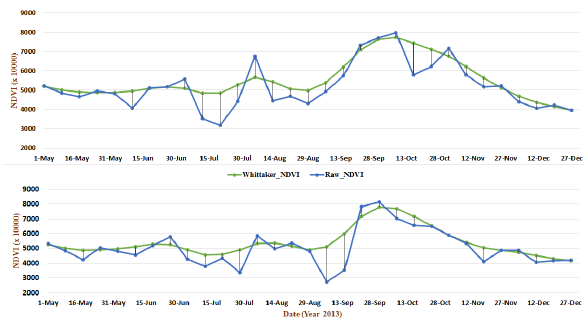
Figure 2: VI time series before and after applying smoothing